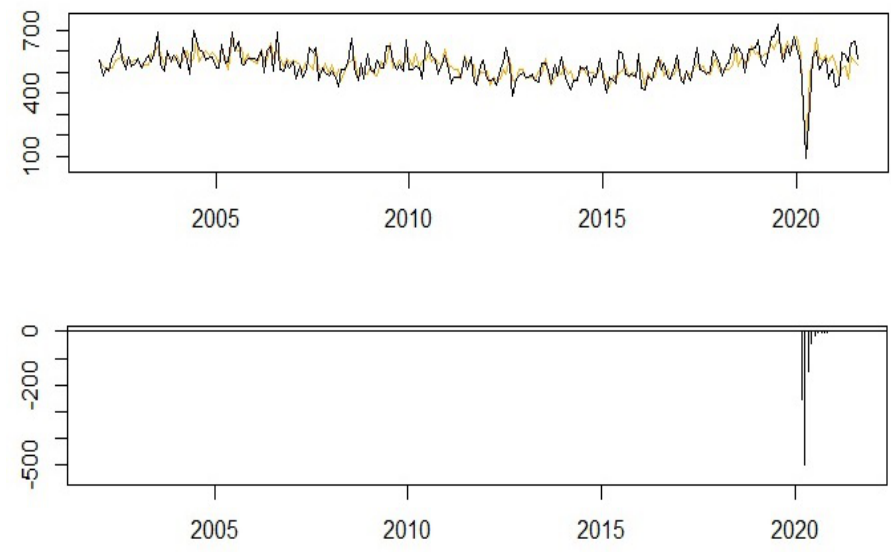
Figure 4. Living donor transplant counts (January 2002 to August 2021) with the model fit ( top ) and the estimated COVID-19 effects ( bottom ).